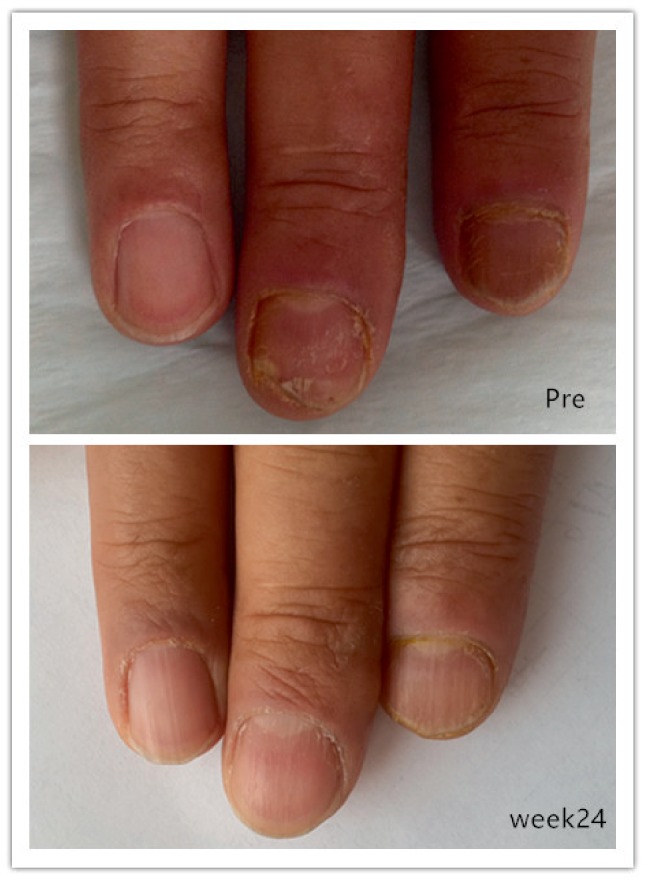
Images before and after 12 treatment sessions for fingernail onychomycosis.